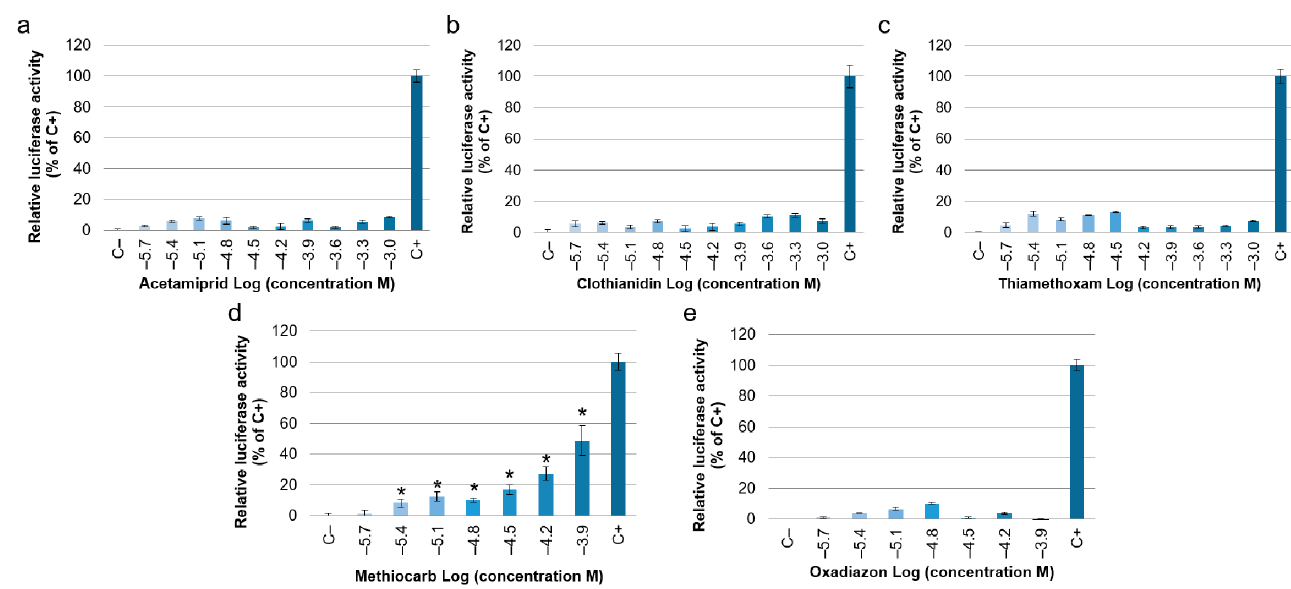
Figure 2. Effect of pesticides on estrogen signaling expressed as estrogenic activity. Estrogenic activity is reported as relative luciferase activity with respect to positive control (C+ = 17 β -estradiol 10 − 8 M, relative luciferase activity of C+ = 100%): ( a ) Acetamiprid; ( b ) Clothianidin; ( c ) Thiamethoxam; ( d ) Methiocarb; ( e ) Oxadiazon. Data are presented as means ± standard deviations *: p -value < 0.05 vs. negative control (C − ) (Kruskal–Wallis followed by post hoc Dunnett’s test).